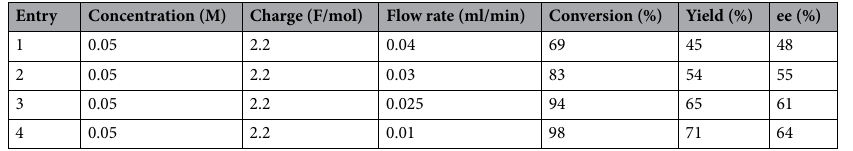
Table 4. Continuous flow elecrochemical screening of flow rate results with platinum as both the anode and cathode. Constant parameters: electrodes (Pt cathode/Pt anode), temperature (rt), current (2.2 F/mol), concentration (0.05 M) and electrolyte (NaOMe, catalytic amount). General procedure is followed as given